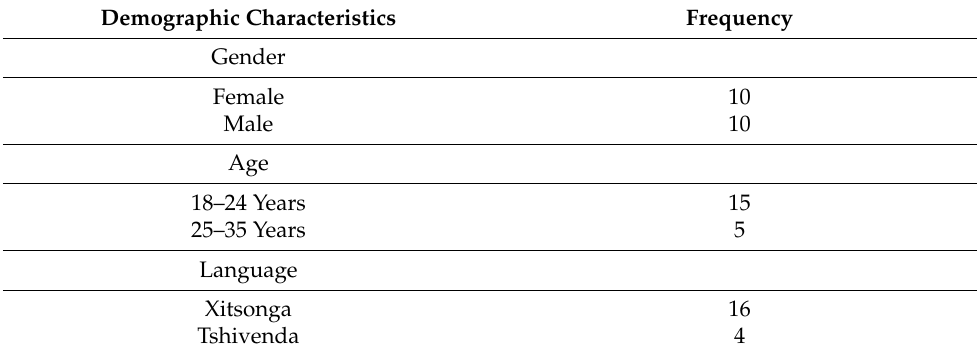
Table 2. Demographic